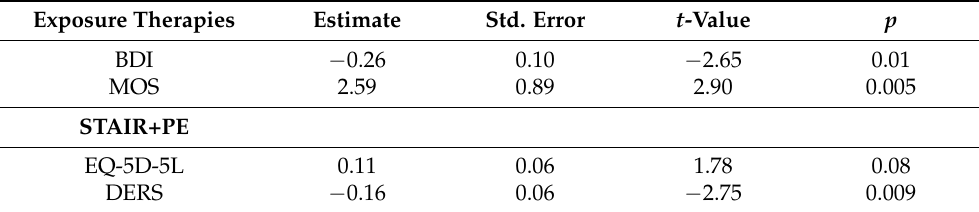
Table 3. Final prediction models of exposure therapies and STAIR+PE with calculated change in PCL-5 score baseline to posttreatment as the outcome